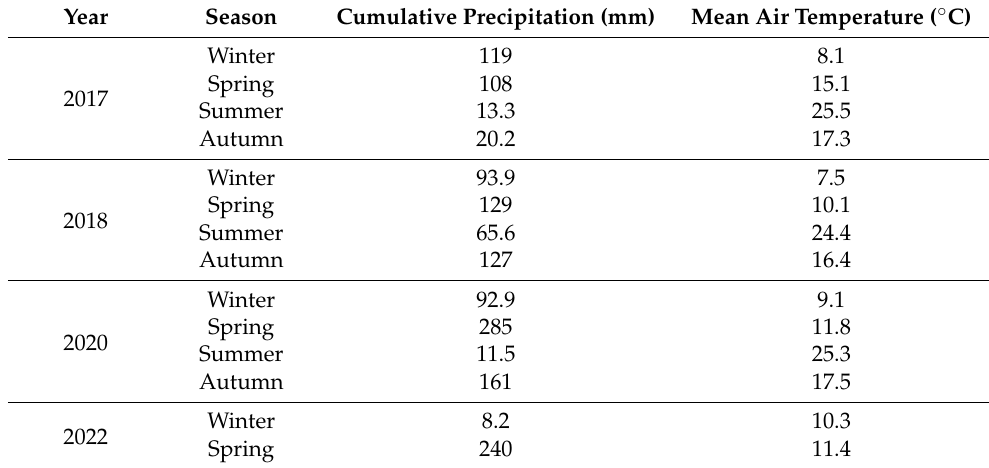
Table 1. Cumulative precipitation and mean air temperature on the seasonal scale in the study period (Sierra de Los Donceles forest, Castilla La Mancha,